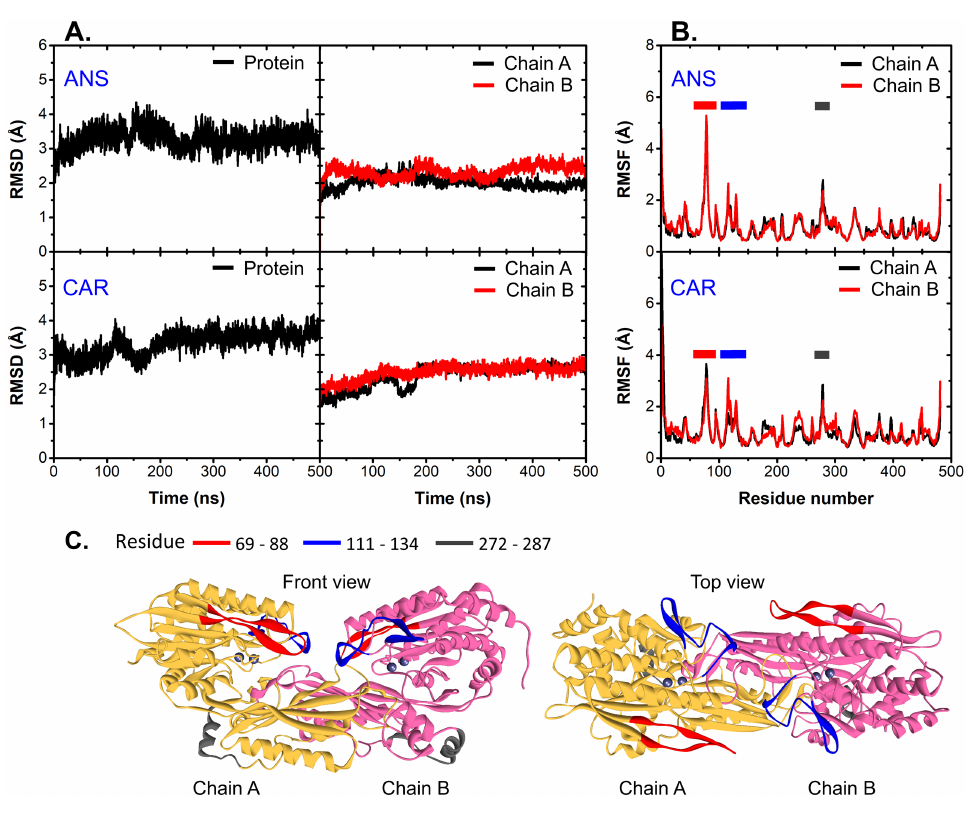
Figure 2 RMSD and RMSF. (A) C-alpha RMSDs of the whole protein (left) and each chain (right). (B) is the C-alpha RMSFs of all systems where the highly fluctuated regions are shown as cartoon representatives in (C). Full-size DOI: